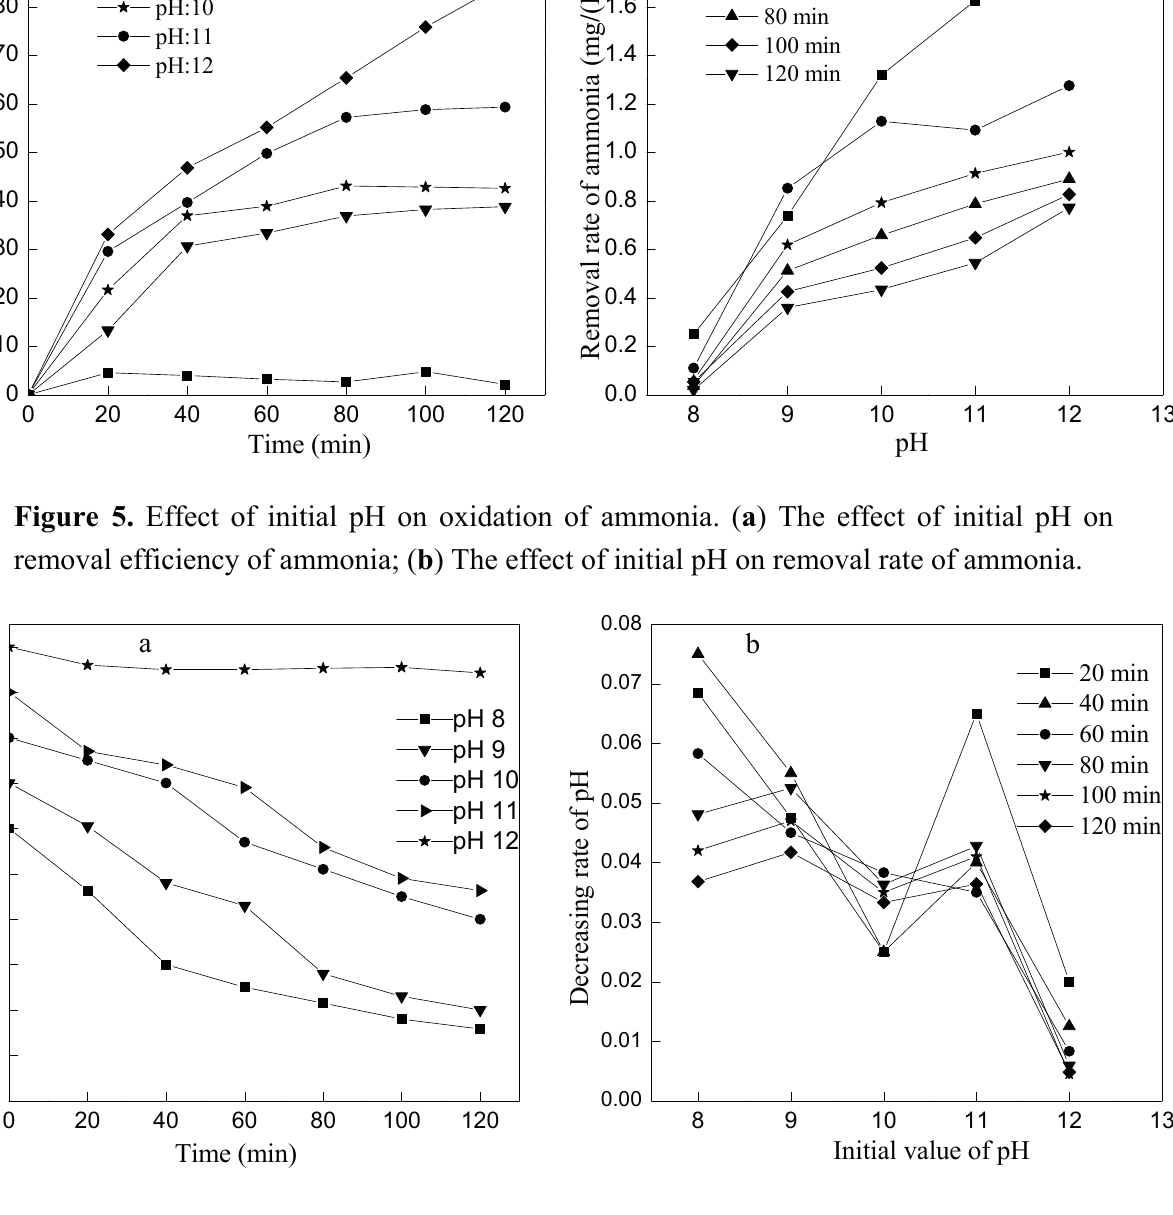
Figure 6. Variation of pH with reaction time at different initial pH. ( a ) The changes of pH at different initial pH; ( b ) The decreasing rate of pH at different initial